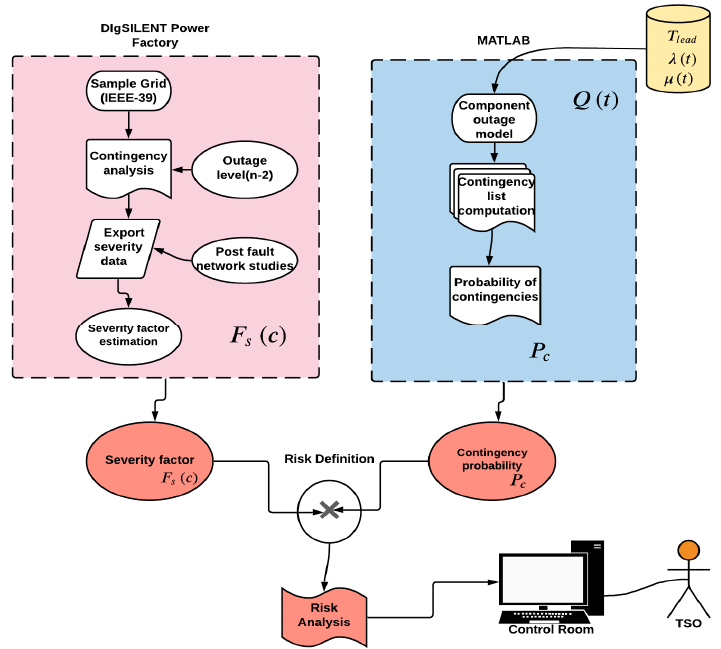
Figure 1. Schematic algorithm flow of operational risk assessment.